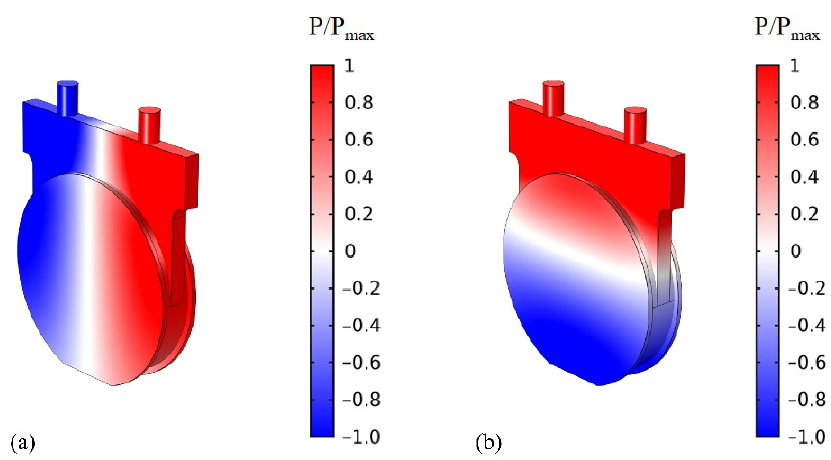
Table 2. The natural frequencies (in Hz) corresponding to the acoustic mode shape of the single ‐ cavity unit within the compartmented cavity design.